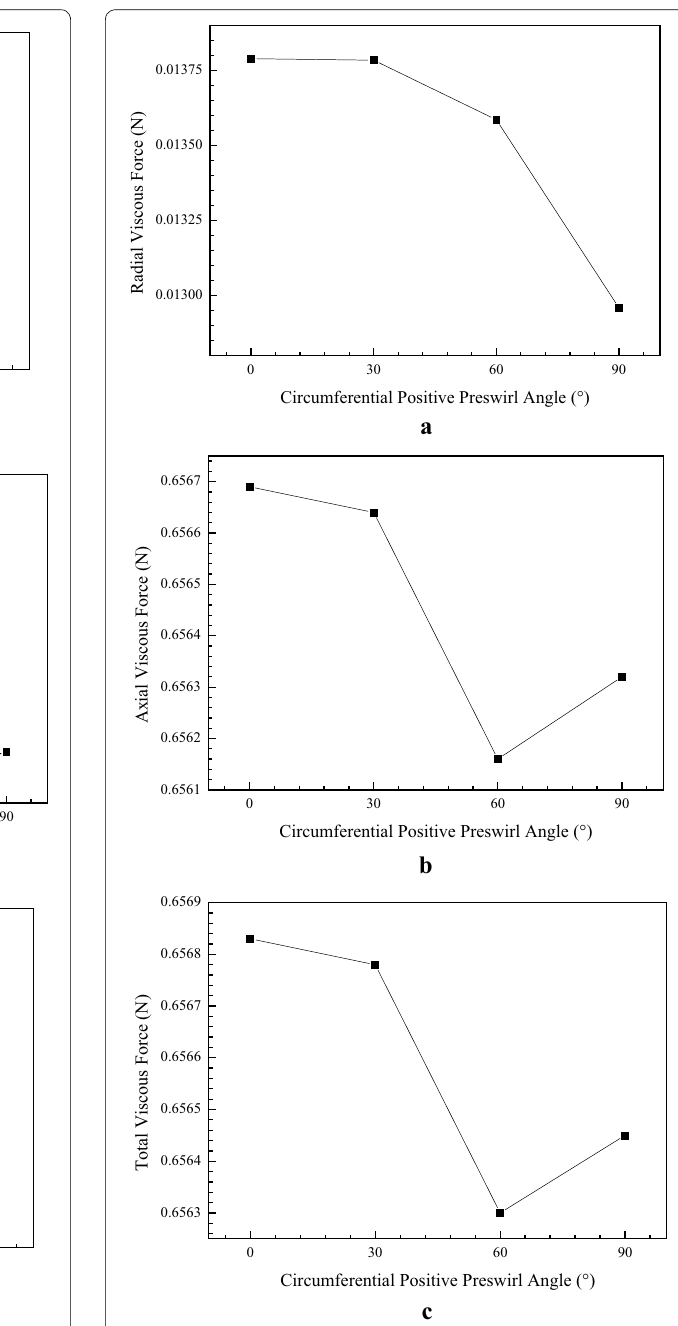
Figure 13 Viscous forces versus circumferential positive pre-swirl angle: a radial viscous force; b axial viscous force; c total viscous